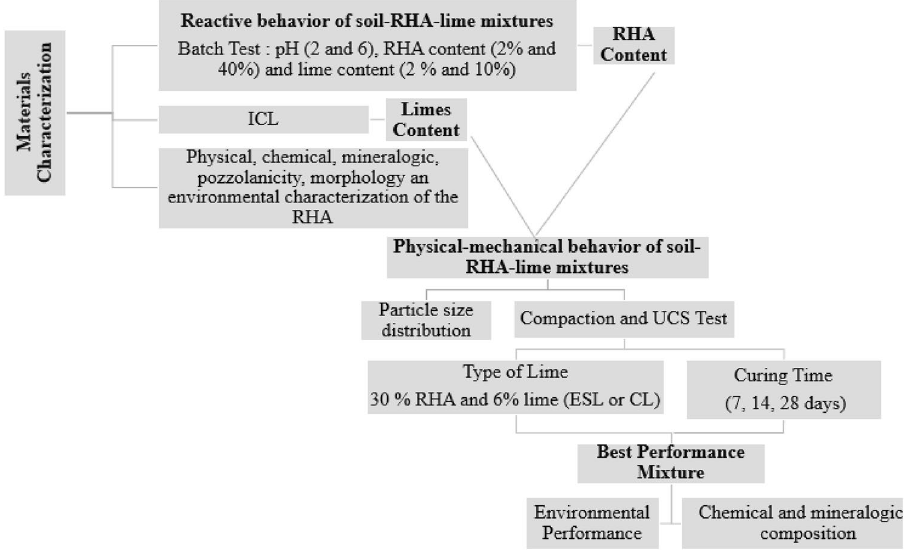
Figure 1. Study methodology